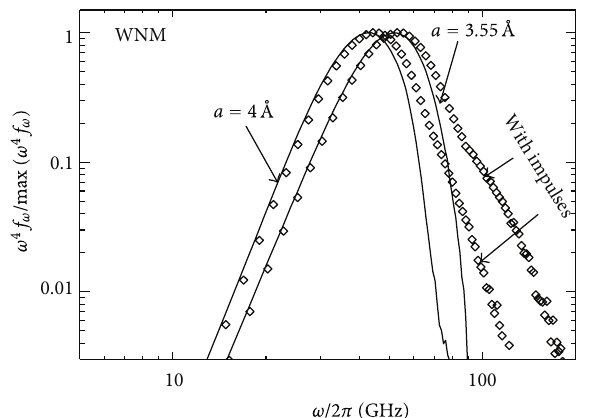
F 2: Effect of impulsive torques due to collisions with ions in the WIM. Figure reproduced from